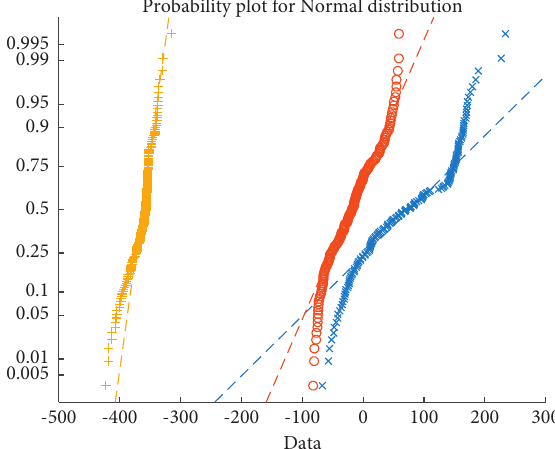
Figure 6: Probability